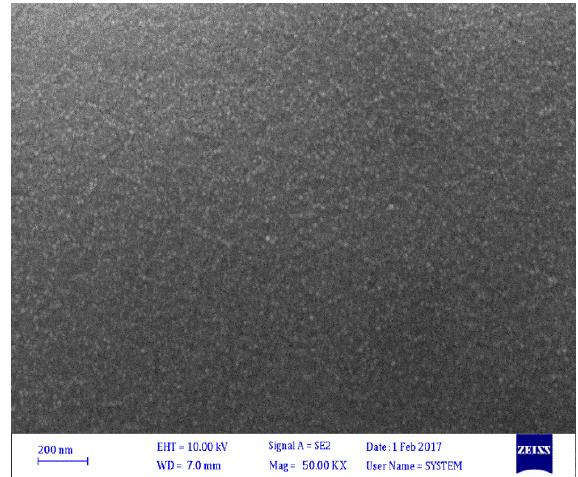
Fig. 9. SEM image of the Surface morphology of CS/GEL/H/AV thin film Figure 9. SEM image of the Surface morphology of CS/GEL/H/AV thin film